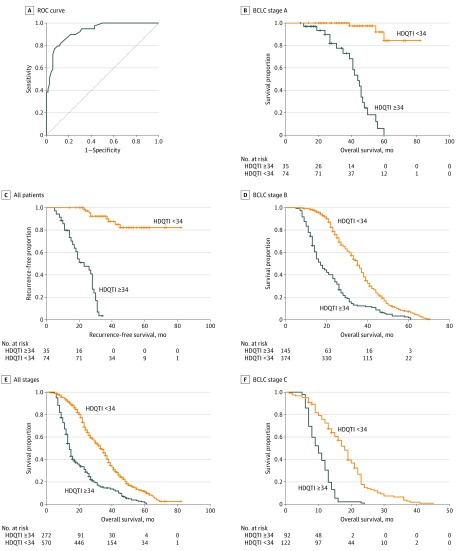
Hepatitis B Virus (HBV) DNA Quantitation-Time Index (HDQTI) for HBV-Related Hepatocellular Carcinoma (HCC) TherapyA, Receiver operating characteristic (ROC) curve of the HDQTI score in estimating cured HBV-related HCC recurrence in patients with Barcelona Clinic Liver Cancer (BCLC) stage A disease. The area under curve was 0.928 (95% CI, 0.91–0.99) The diagonal line indicates the fase-positive rate. B, Kaplan-Meier curves of the HDQTI in patients with BCLC stage A HBV-related HCC recurrence-free survival. C-F, Kaplan-Meier curves of the HDQTI in HBV-related HCC overall survival for all patients (C), patients with BCLC stage A disease (D), patients with BCLC stage B disease (E), and patients with BCLC stage C disease (F). Hash marks indicate censored data.